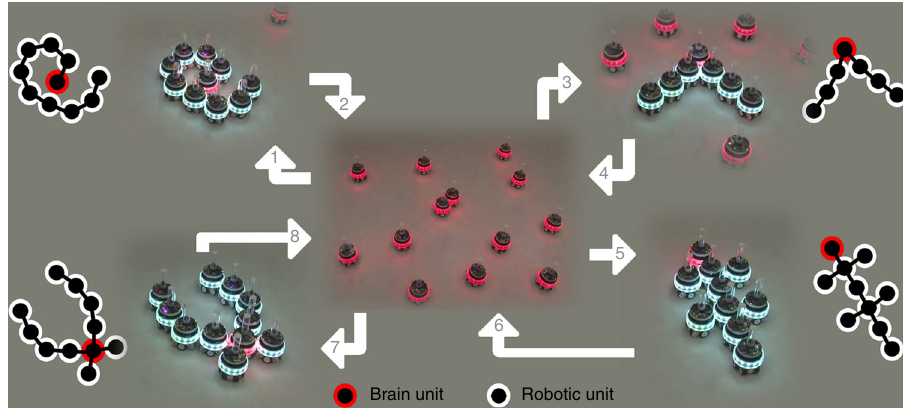
Fig. 1 The mergeable nervous system concept. MNS robots are able to physically connect to one another and thereby merge into larger MNS robots of different shapes and sizes. In step 1, MNS robots consisting of a single robotic unit ( center ) self-assemble into a larger spiral-shaped MNS robot with a single brain unit ( upper left corner ). In step 2, the MNS robot splits and each of its robotic units becomes a one-unit MNS robot. The process is repeated three times (steps 3 – 8) during which the MNS robots merge into three larger MNS robots with different shapes (Supplementary Movie 1 for a video recording). The schematics show the brain unit ( in red ) and robotic units of each of the larger MNS robots and their merged robot nervous